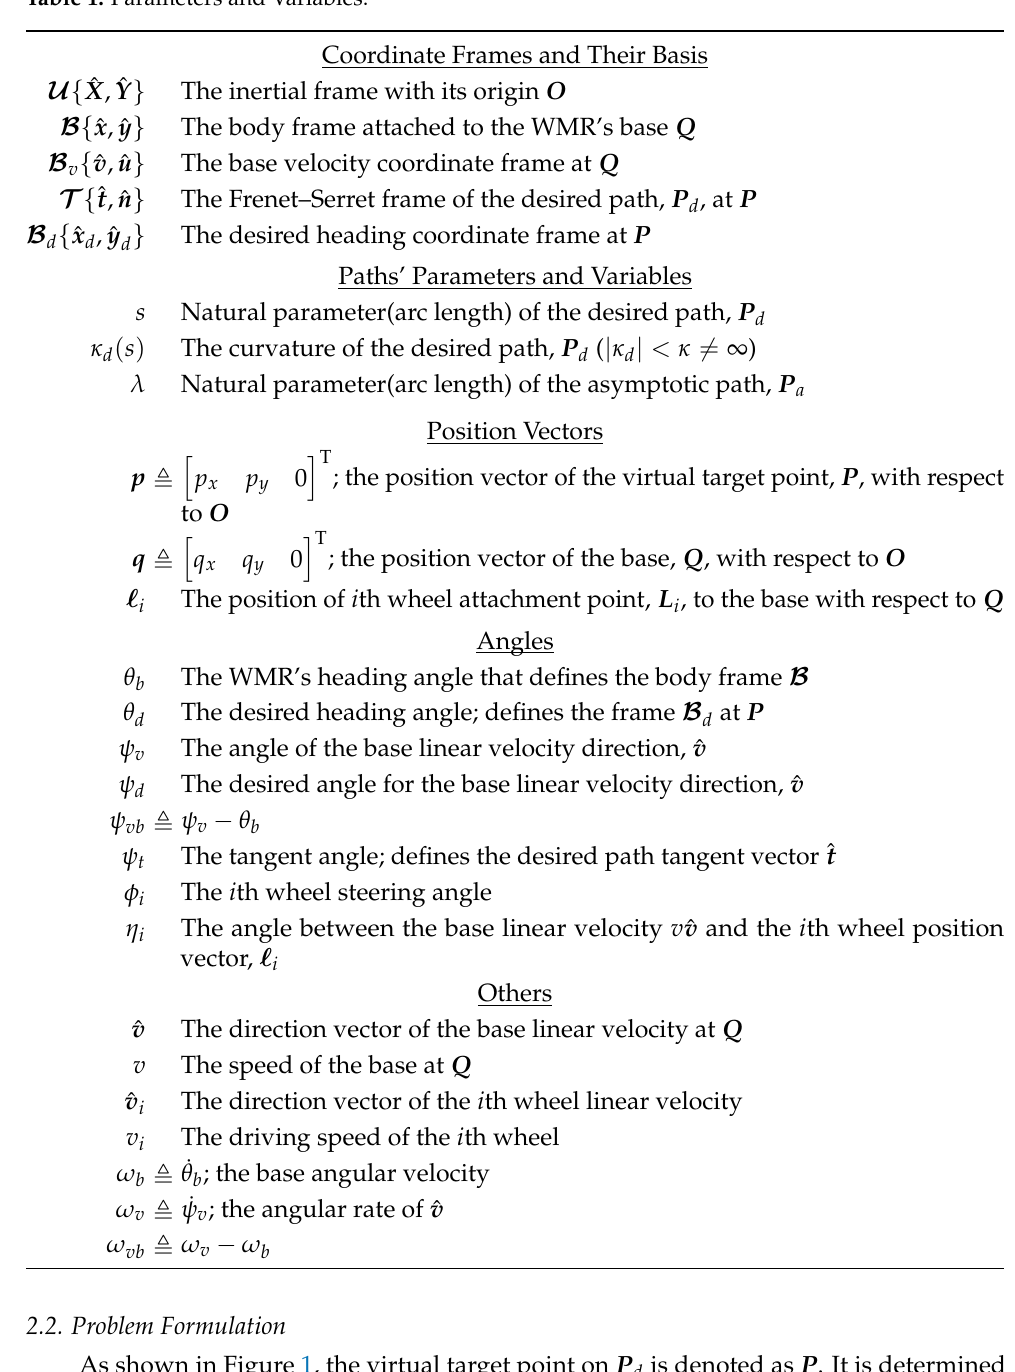
Table 1. Parameters and